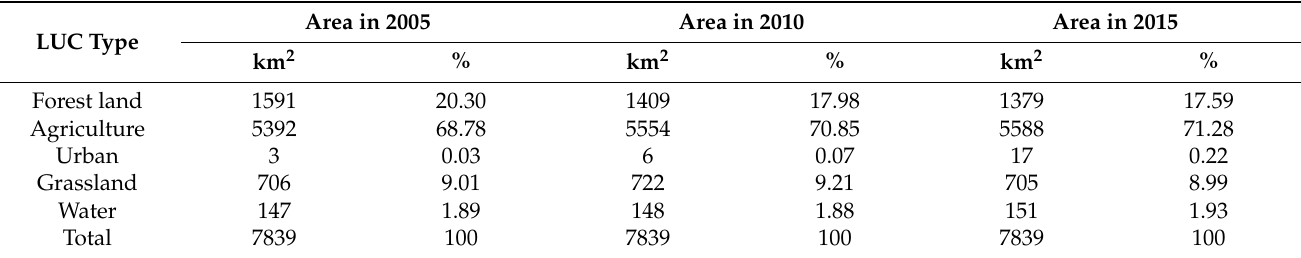
Table 3. LUC area of the BRB in the years of 2005, 2010, and 2015.